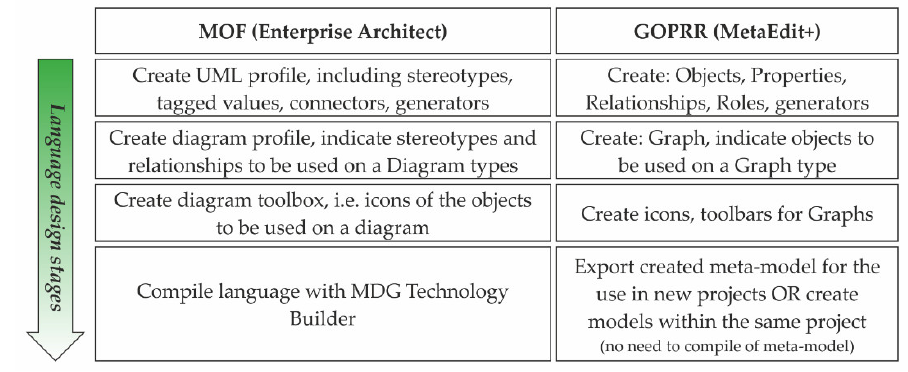
Figure 8. Two workflows for metamodeling design process.